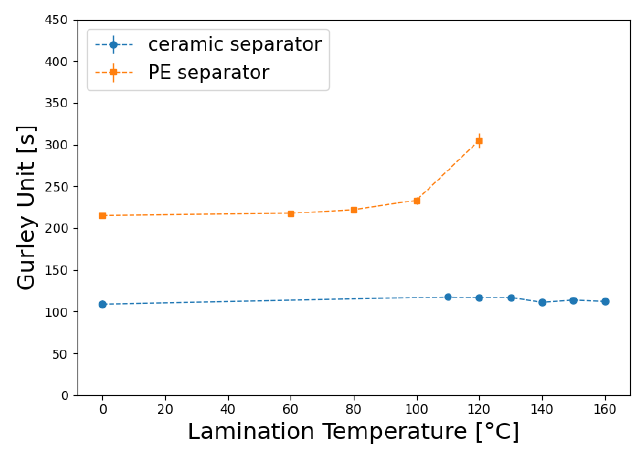
Figure 1. Dependence of air permeability on different lamination temperatures at a line force of 8 N/mm. Gurley measurements were performed using 100 cm 2 air